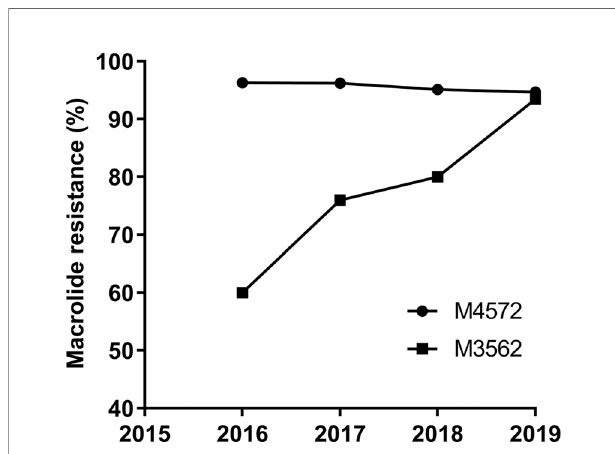
FIGURE 2 | Macrolide resistance rates of MP with M4572 and M3562 types between 2016 and 2019 (N=1,014).